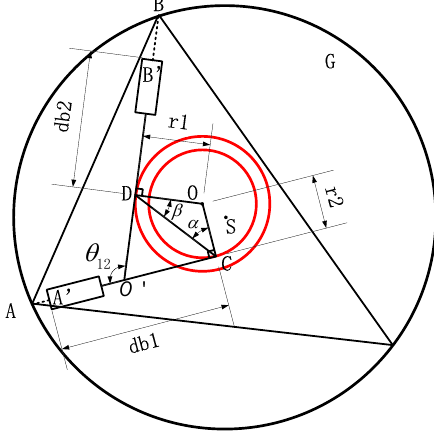
Figure 2. The actual mathematical model.